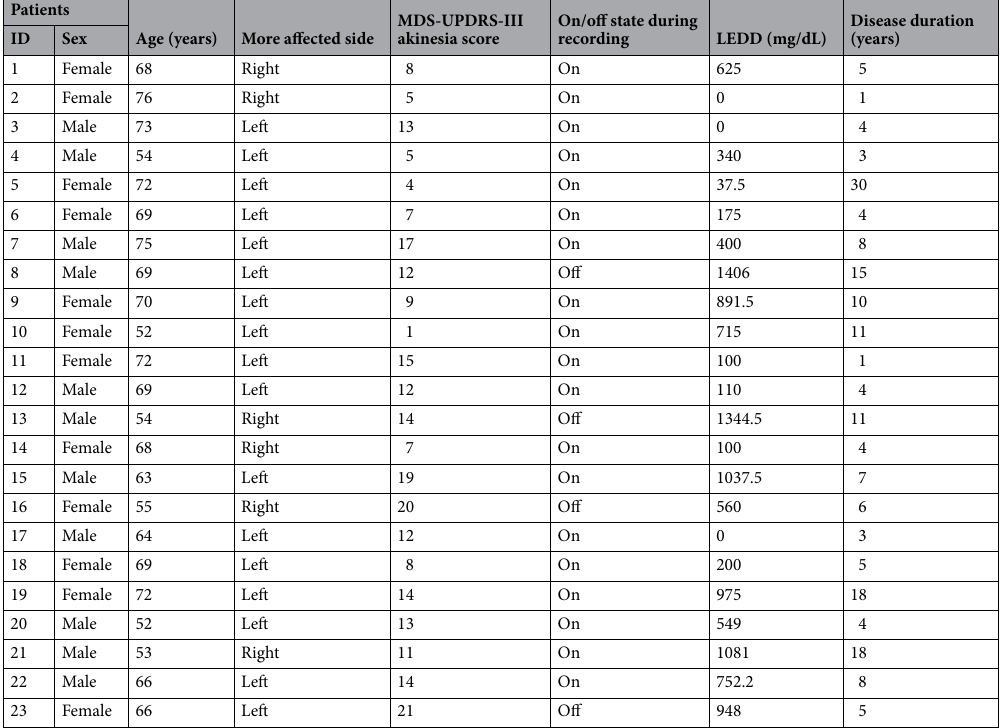
Table 1. Clinical characteristics of the participants with Parkinson’s disease. MDS-UPDRS-III akinesia score sum of akinesia-related scores on the Movement Disorder Society–sponsored revision of the Unified Parkinson’s Disease Rating Scale, part III; LEDD levodopa equivalent daily